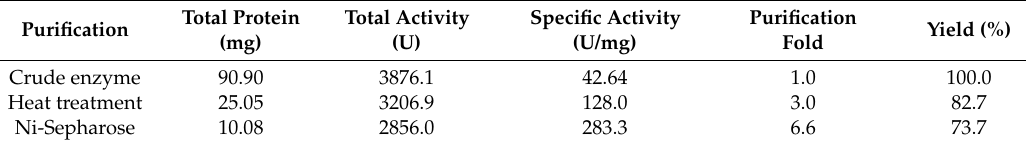
Figure 2. ( A ) The purification of recombinant GSJ from E. coli BL21 (DE3). Lane M, molecular weight markers; Lane 1, E. coli BL21-pET28a; Lane 2, crude enzyme; Lane 3, heat treatment; Lane 4, purified GSJ. ( B ) MALDI-TOF analyses of recombinant GSJ. The major signals are labelled as [M + 2H] 2+ and [M + H] + , respectively. Table 1. Purification scheme of recombinant